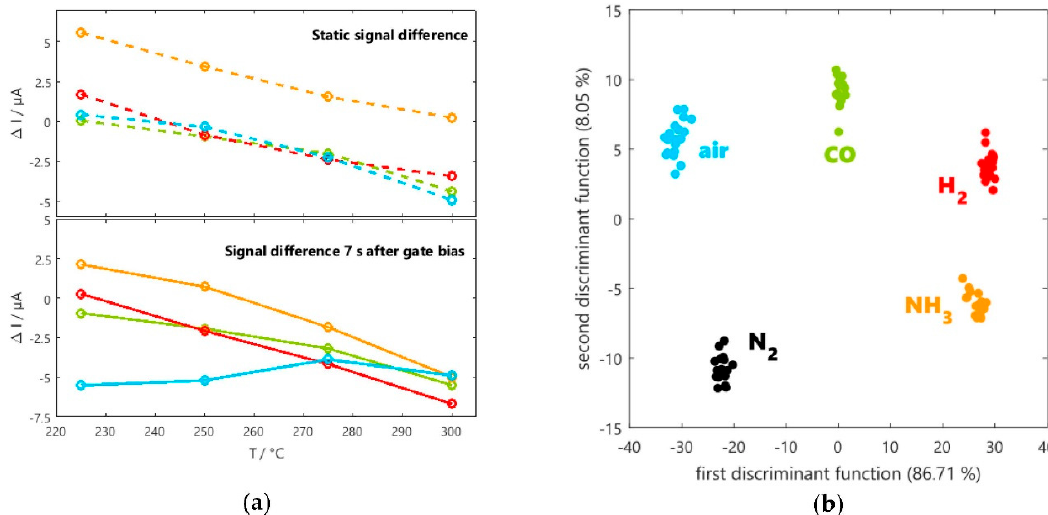
Figure 3. ( a ) The difference between the signal at positive and negative gate bias decreases with the same rate for all gases (color legend given in ( b )), while dynamic effects (represented by the difference between baseline at negative gate bias and the signal 7 s after the step) are gas dependent. ( b ) Six slopes have been extracted at different points in time from the signals (not shown). Using them as features for an LDA discriminates all five gases perfectly from each